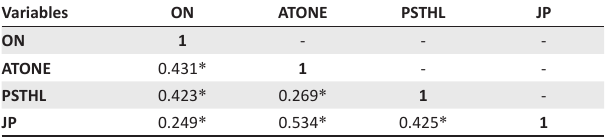
TABLE 4: Inter-correlations for independent and dependent variables.